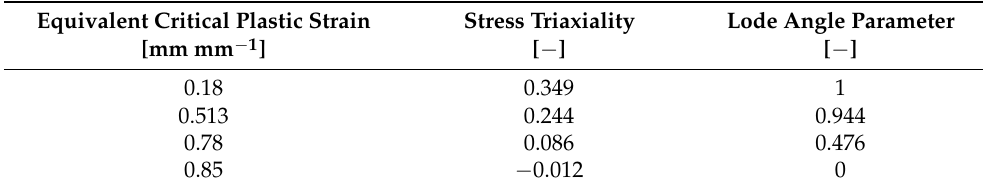
Table 3. Equivalent critical plastic strain and Lode angle parameter variation with stress triaxiality for the Arcan